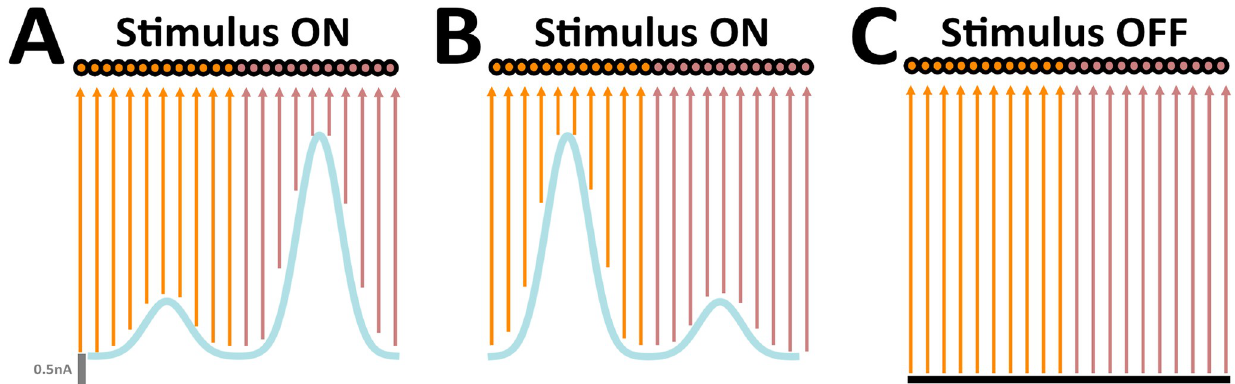
Fig 2. Sensory afferents to the embodied network. (A) ON stimulus (blue). (B) Same as (A), but instead peaks are interchanged (C) OFF stimulus (black); orange, subpopulation 1; brown, subpopulation 2. Parameters: R counter-clockwise rotations, N = 500, σ = 35. Figure adapted from